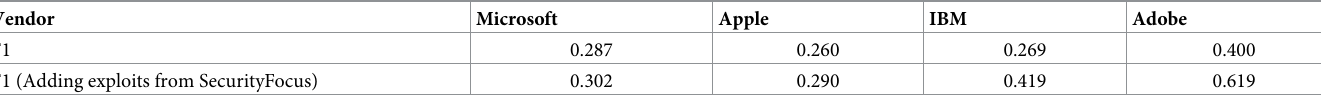
Table 10. Performance metrics for prediction of different vendors by year using sliding